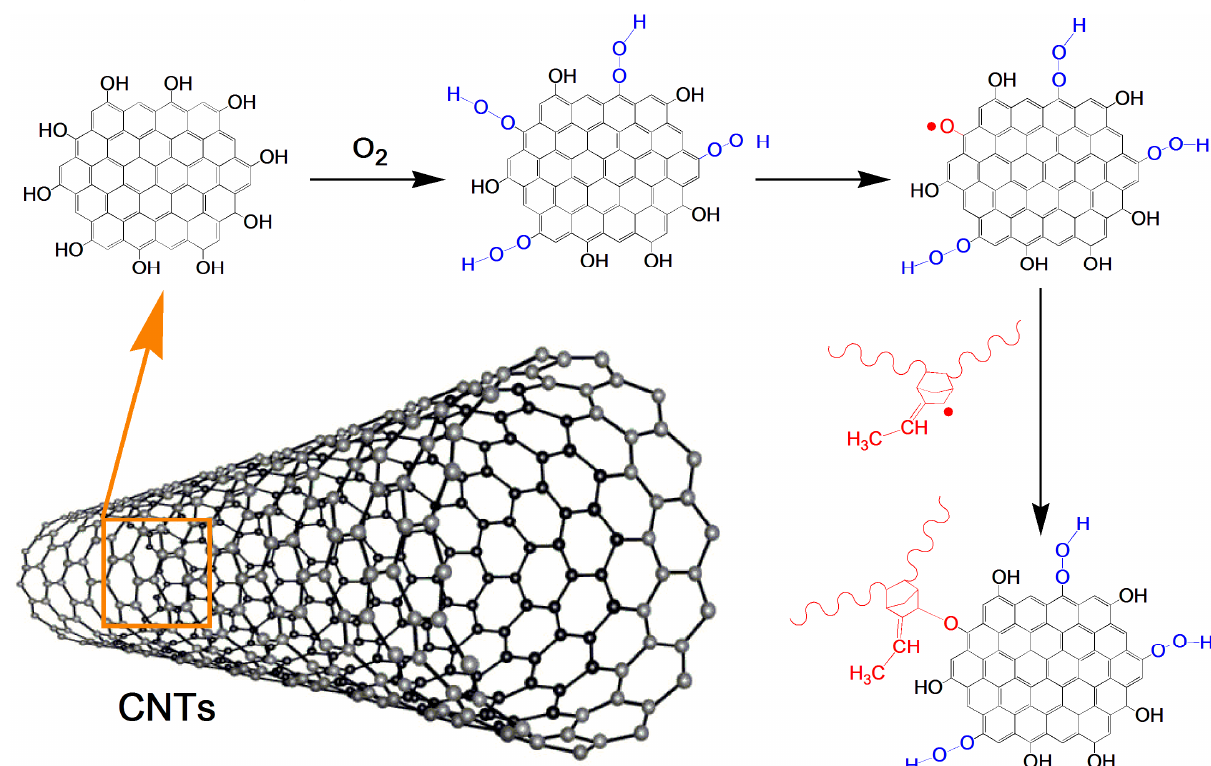
Figure 5. Possible thermo-oxidative aging mechanism for EPDM filled with CNTs.